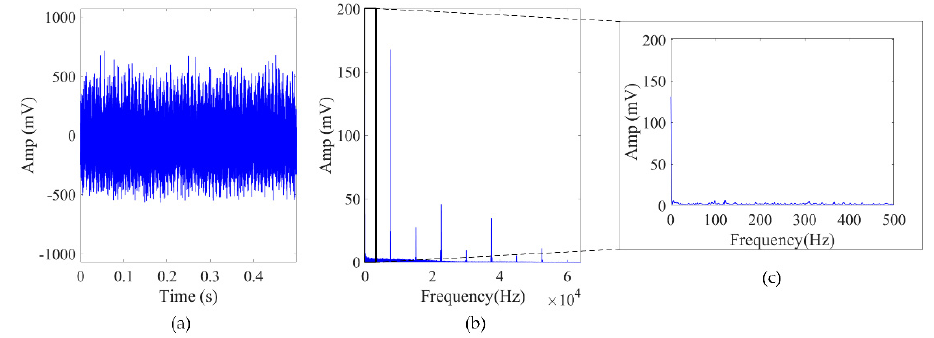
Figure 4. ( a ) The original signal waveform, ( b ) its frequency spectrum, and ( c ) partial